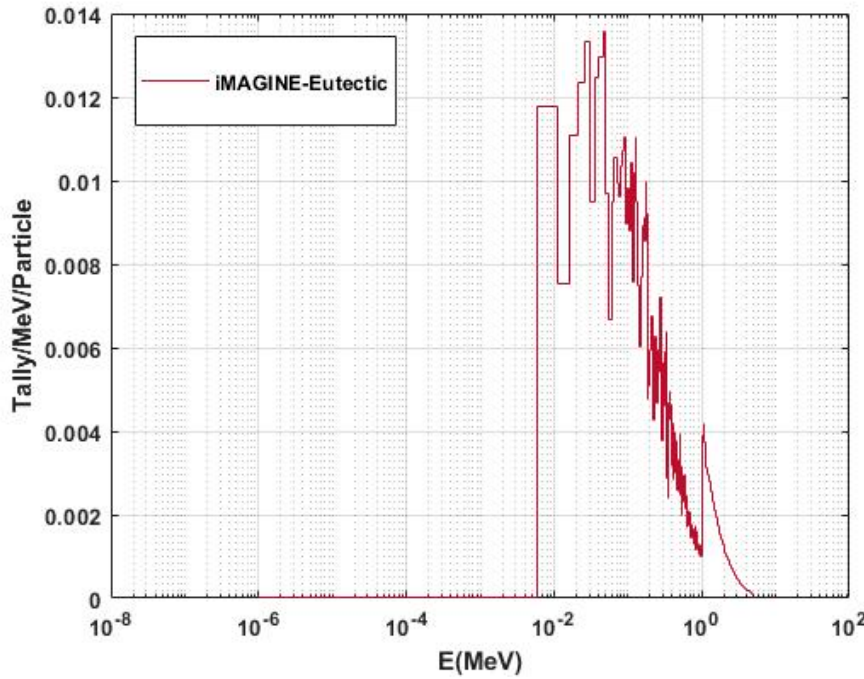
Figure 6. Neutron fluxenergy spectrum for iMAGINE–Eutectic salt fuel system.